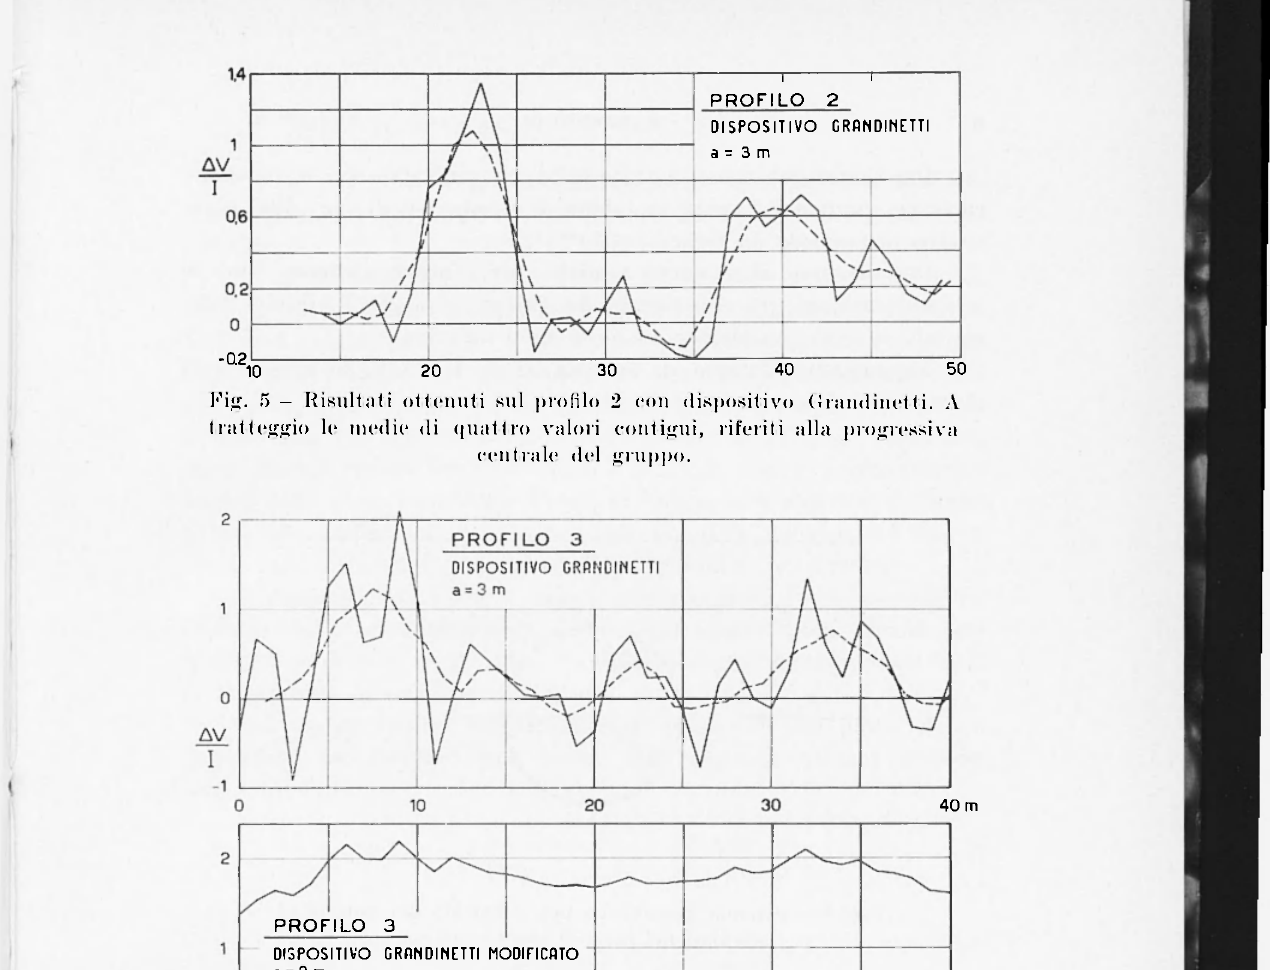
Fig. (i Risultati ottenuti sul piotilo 3 con dispositivo Grandinetti e Grandinetti modificato. A tratteggio le inedie di quattro valori con- tigui, riferiti alla progressiva centrale del gruppo.